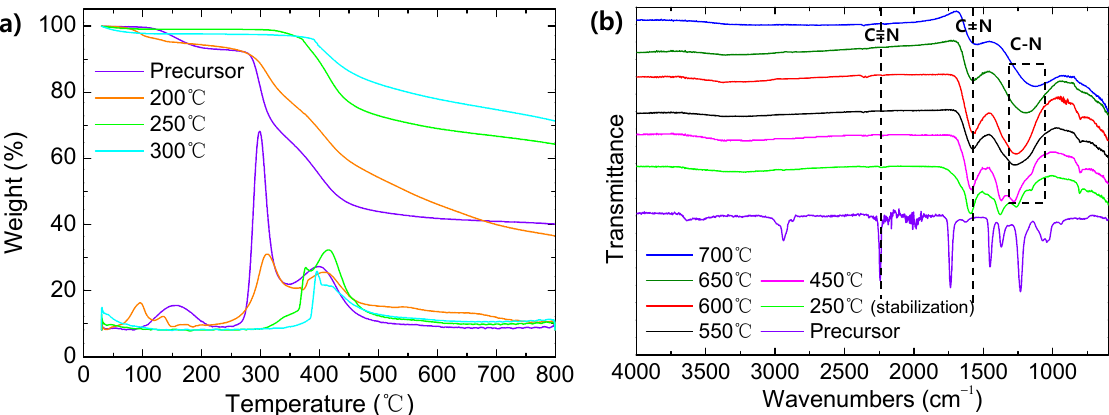
Figure 4. ( a ) TGA analysis and of stabilized PAN and ( b ) ATR-FTIR analysis of the pristine, stabilized PAN, and CMS.